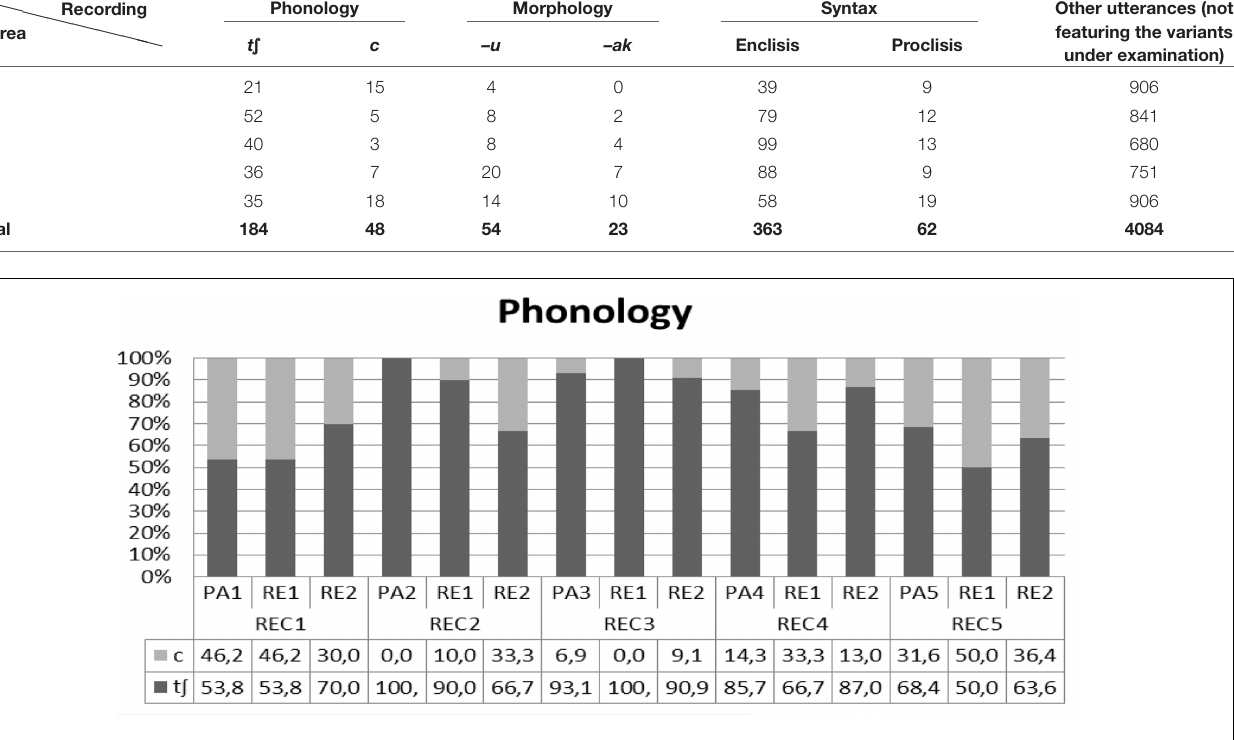
FIGURE 3 | Individual performance for each participant in phonology.